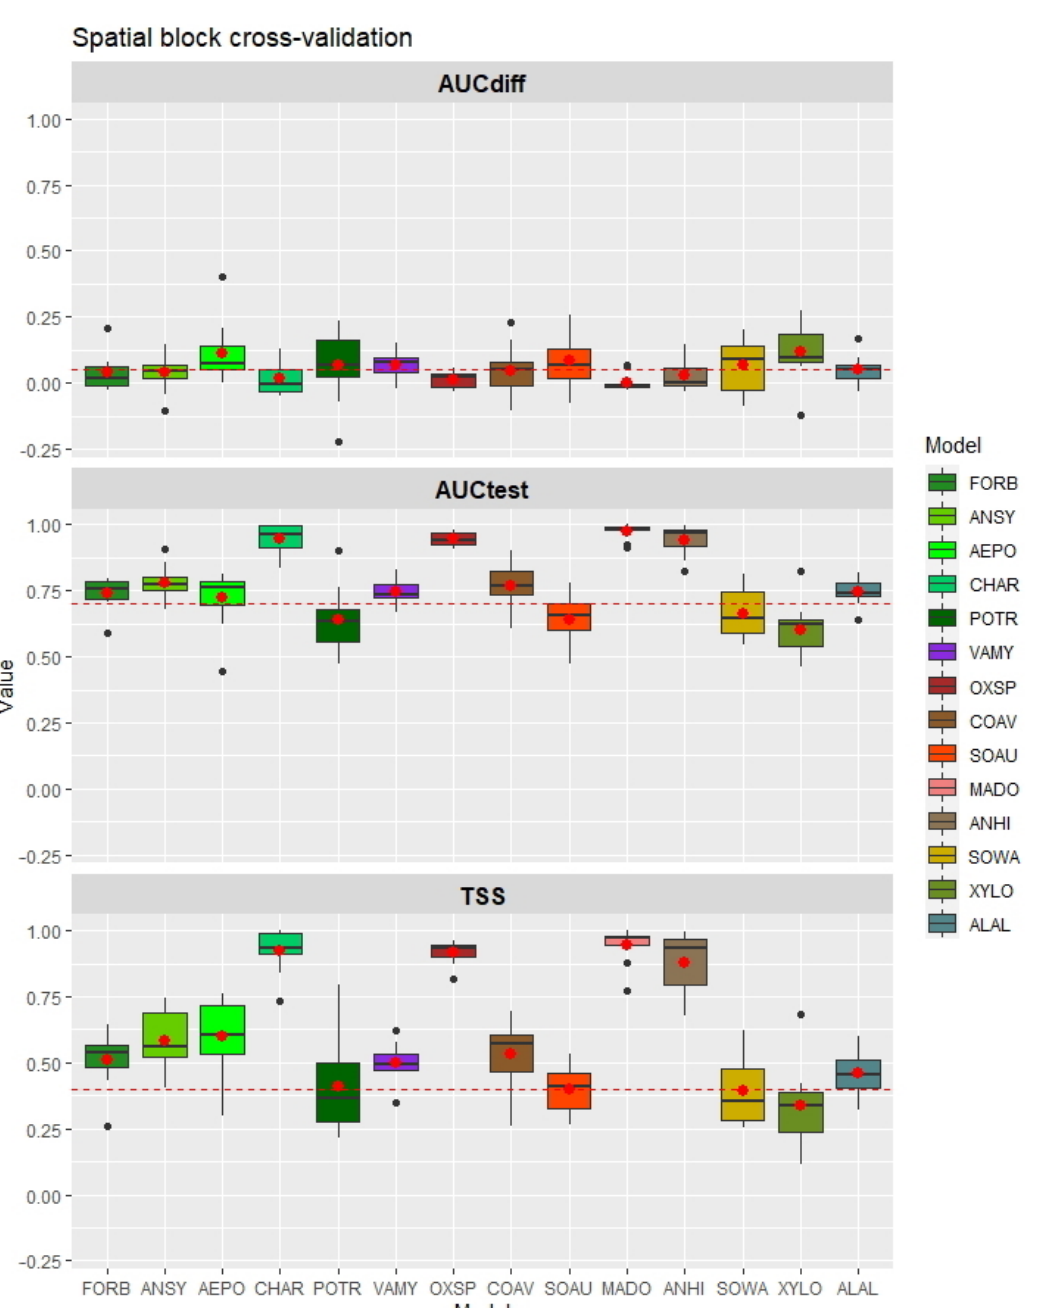
Figure 3. Spatial block cross-validation estimates for 14 food-probability models for the brown bear in the Central Forest State Nature Reserve (West-European Russia) in 2008–2020. Means (red dots) and medians (black lines), first and third quartiles (lower and upper hinges), 1.5 × IQR (inter-quartile range) from the hinges (whiskers) and outliers (black dots) are shown. The red dotted lines correspond to the threshold values for the AUC test (0.7), AUC diff (0.05), and TSS (0.4). AUC test : area under the receiver operator curve for testing data; AUC diff : difference between training and testing AUC; TSS: true skill statistic; Models: FORB— Apiaceae spp., ANSY— Angelica